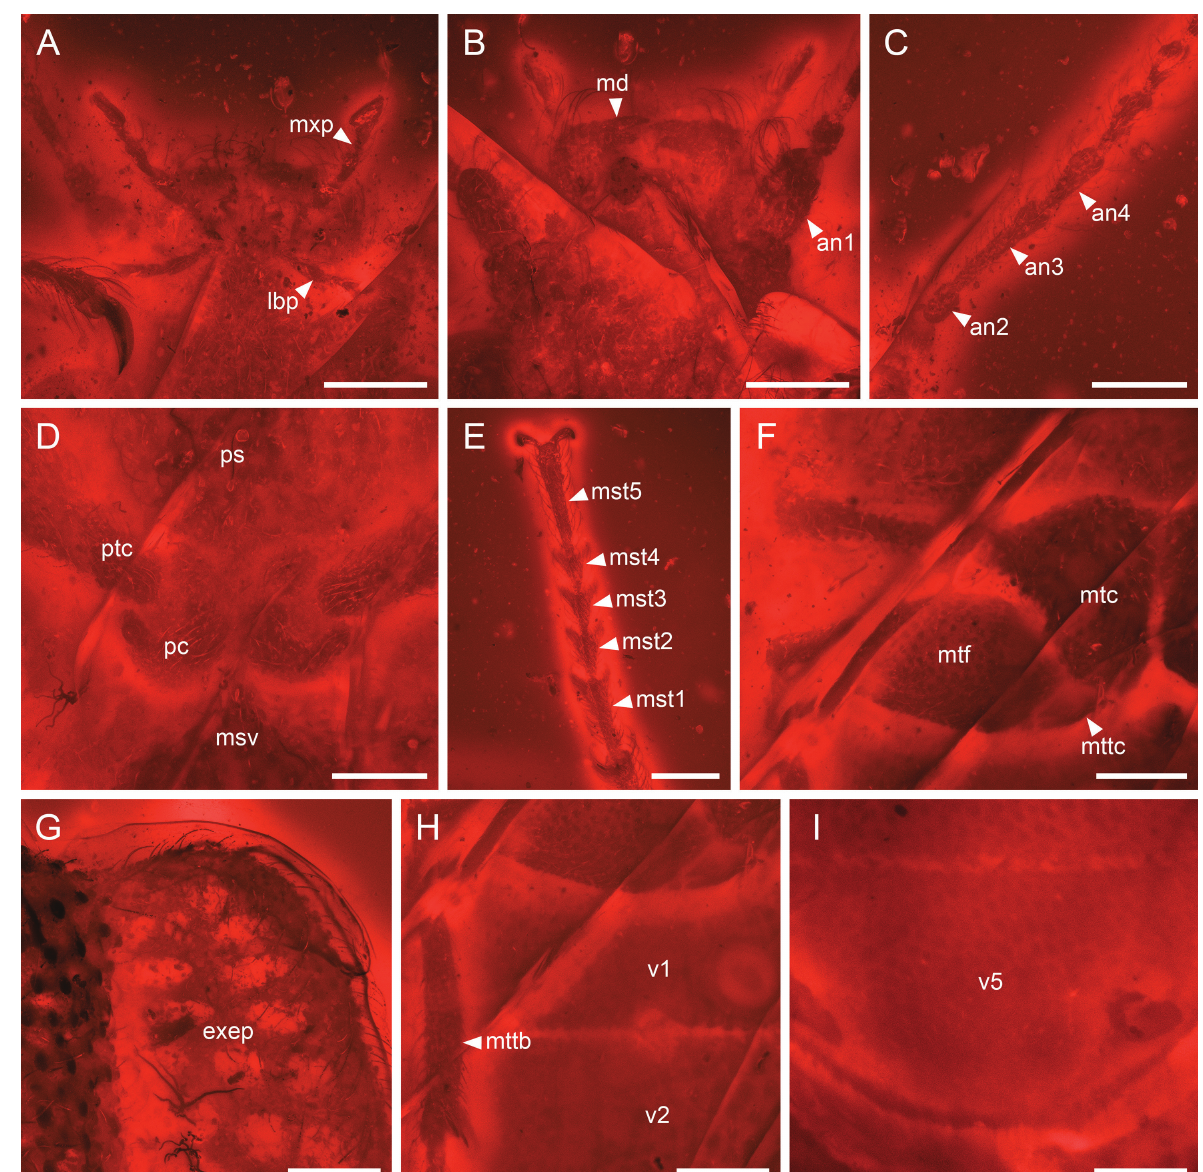
Figure 7. Morphological details of Burmocoleus , under widefield fluorescence. A–H. Burmocoleus prisnyi , NIGP176016; A. Mouthparts, ventral view; B. Mouthparts, dorsal view; C. Antenna, dorsal view; D. Procoxae, ventral view; E. Mesotarsus, ven- tral view; F. Hind leg, ventral view; G. Base of explanate epipleuron, dorsal view; H. Abdominal base, ventral view; I. Burmocoleus zhiyuani , holotype, CNU-COL-BR2014808, abdominal apex, ventral view. Abbreviations: an1–4, antennomeres 1–4; exep, expla- nate epipleuron; lbp, labial palp; md, mandible; mst1–5, mesotarsomeres 1–5; msv, mesoventrite; mtc, metacoxa; mtf, metafemur; mttb, metatibia; mttc, metatrochanter; mxp, maxillary palp; pc, procoxa; ps, prosternum; ptc, protrochanter; sc, scutellum; v1–5, ventrites 1–5. Scale bars: 500